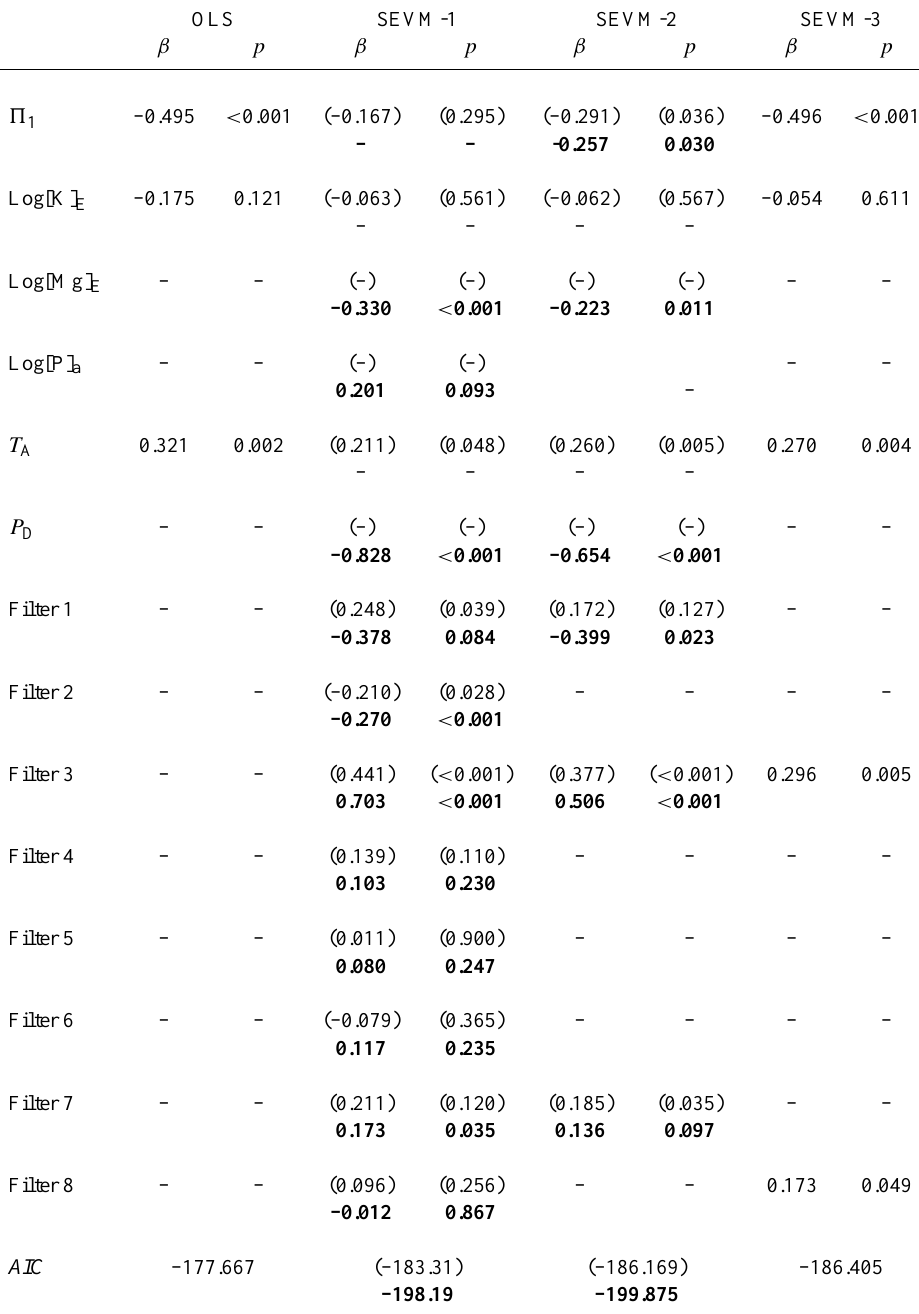
Table 4. Lowest AIC model fits for the prediction of stand wood density with and without the use of spatial filters. For each variable, the upper line gives first the standardised coefficients ( β ) and their level of significance ( p ) from the best OLS model fit, followed by the results (in brackets) when the same OLS model is applied with the preselected spatial filter included. Also shown in bold (second line) for each variable are the values of β and p obtained for the lowest AIC model fit with the spatial filters included. Variables not included in any given model fit are denoted with a “–”. Variables: 5 1 ; Quesada et al (2010)’s first index of soil physical properties; [P] a ; readily available